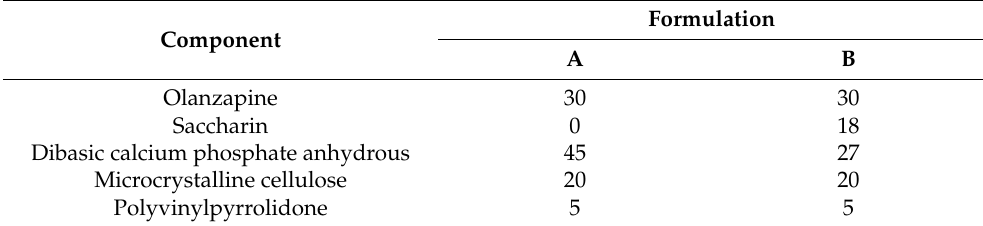
Table 2. Composition (%, w / w ) of formulation A and formulation